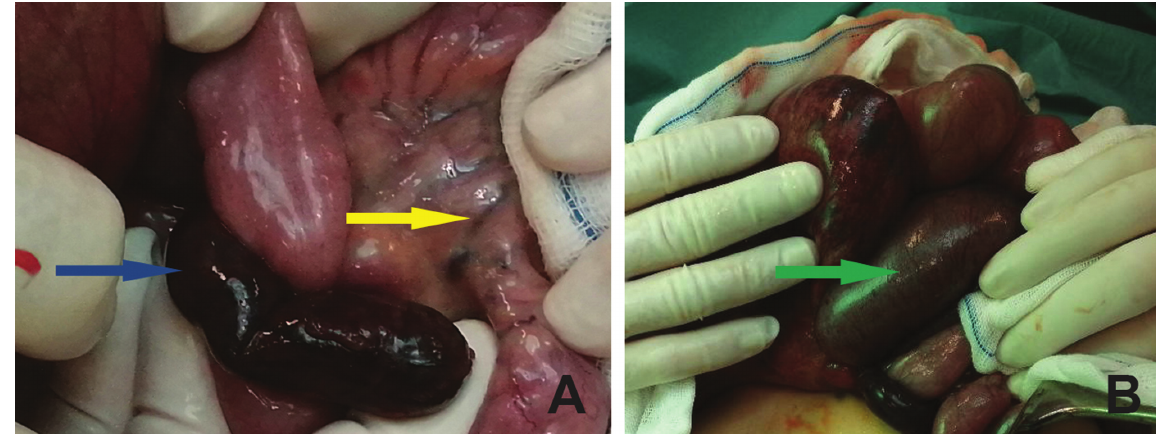
Fig. 1 Necrotic Meckel ’ s diverticulum obstructing the ileum (blue arrow). Thrombosis in the mesenteric vessel (yellow arrow). Dilated necrotic small intestine signed by a white